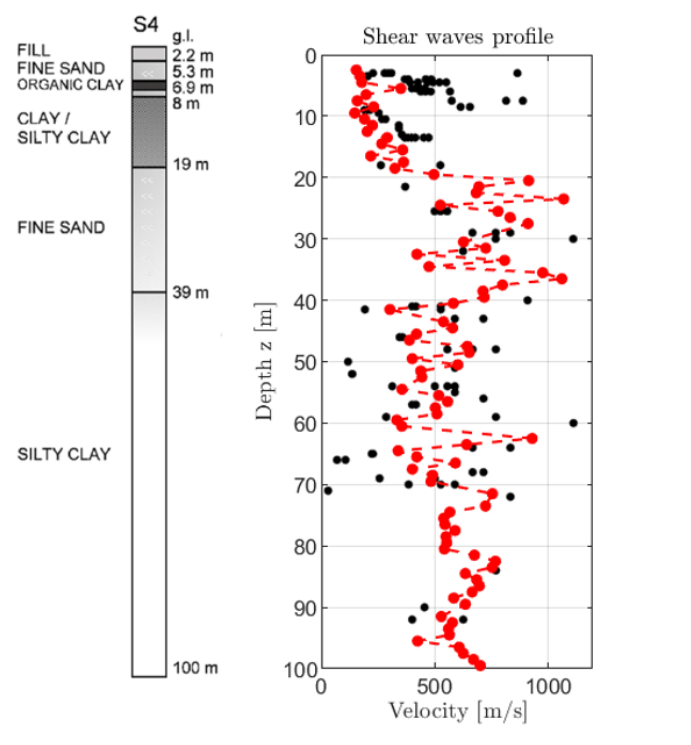
Figure 5. Profile of the shear waves: the red dots correspond to the time series which yield the maximum correlation, the black dots derive from cross-correlations with lower